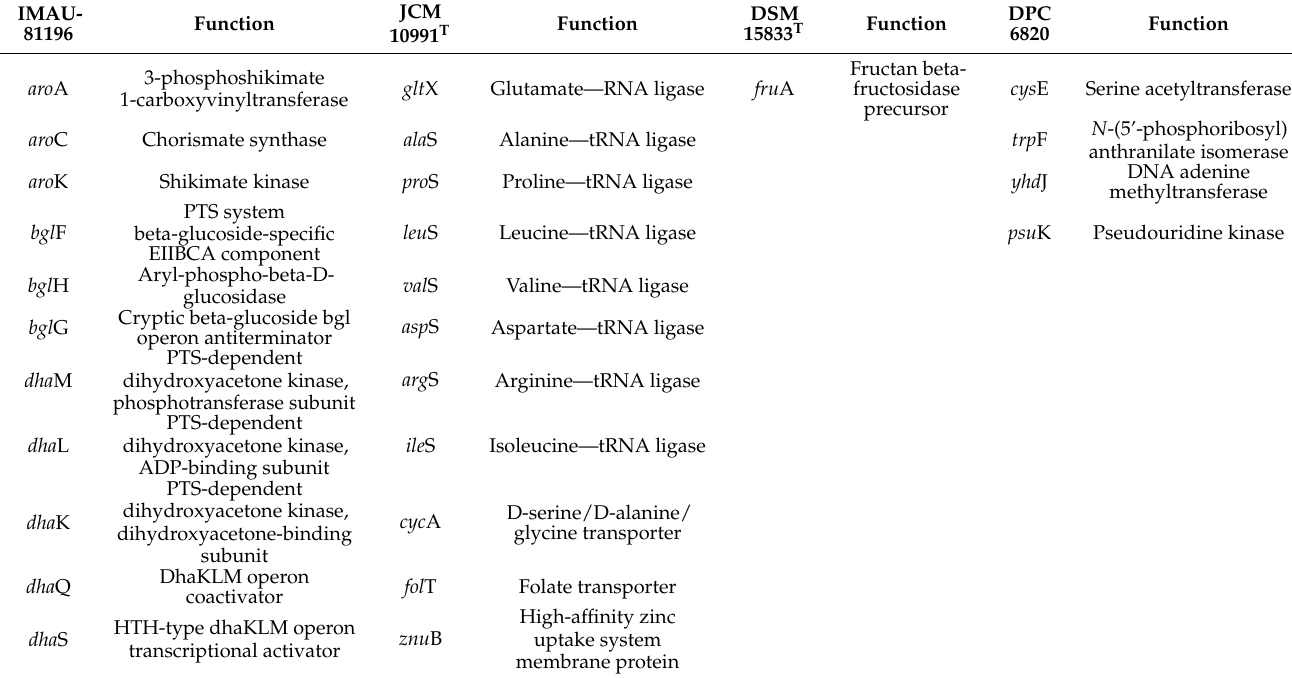
Table 2. Specific functional genes of L. equi